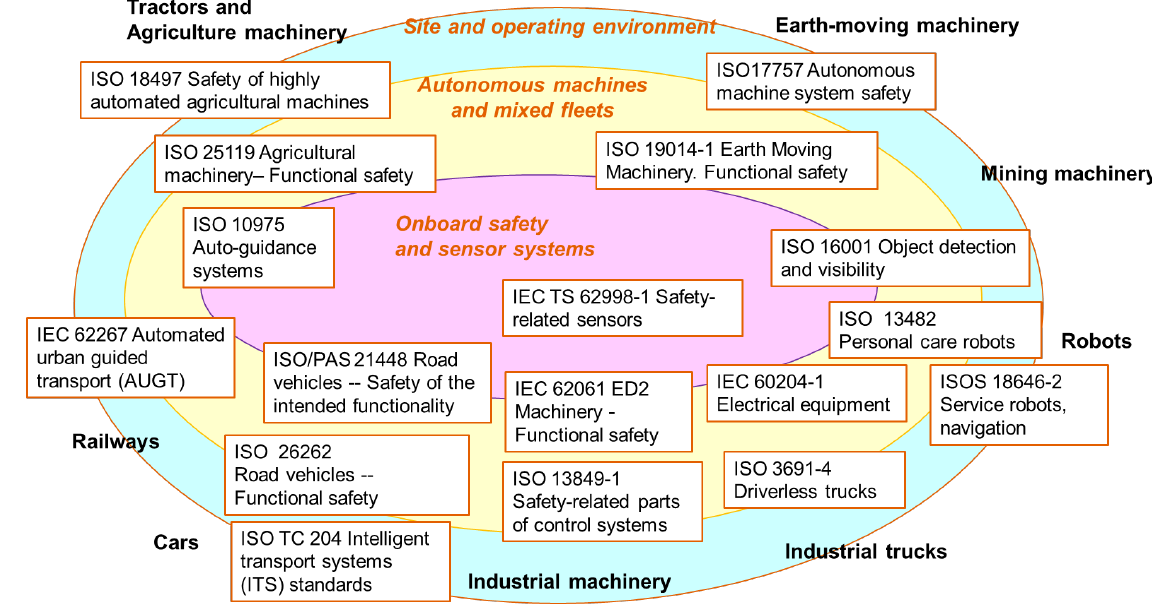
Figure 1: An overview of the current situation in standardization on autonomous